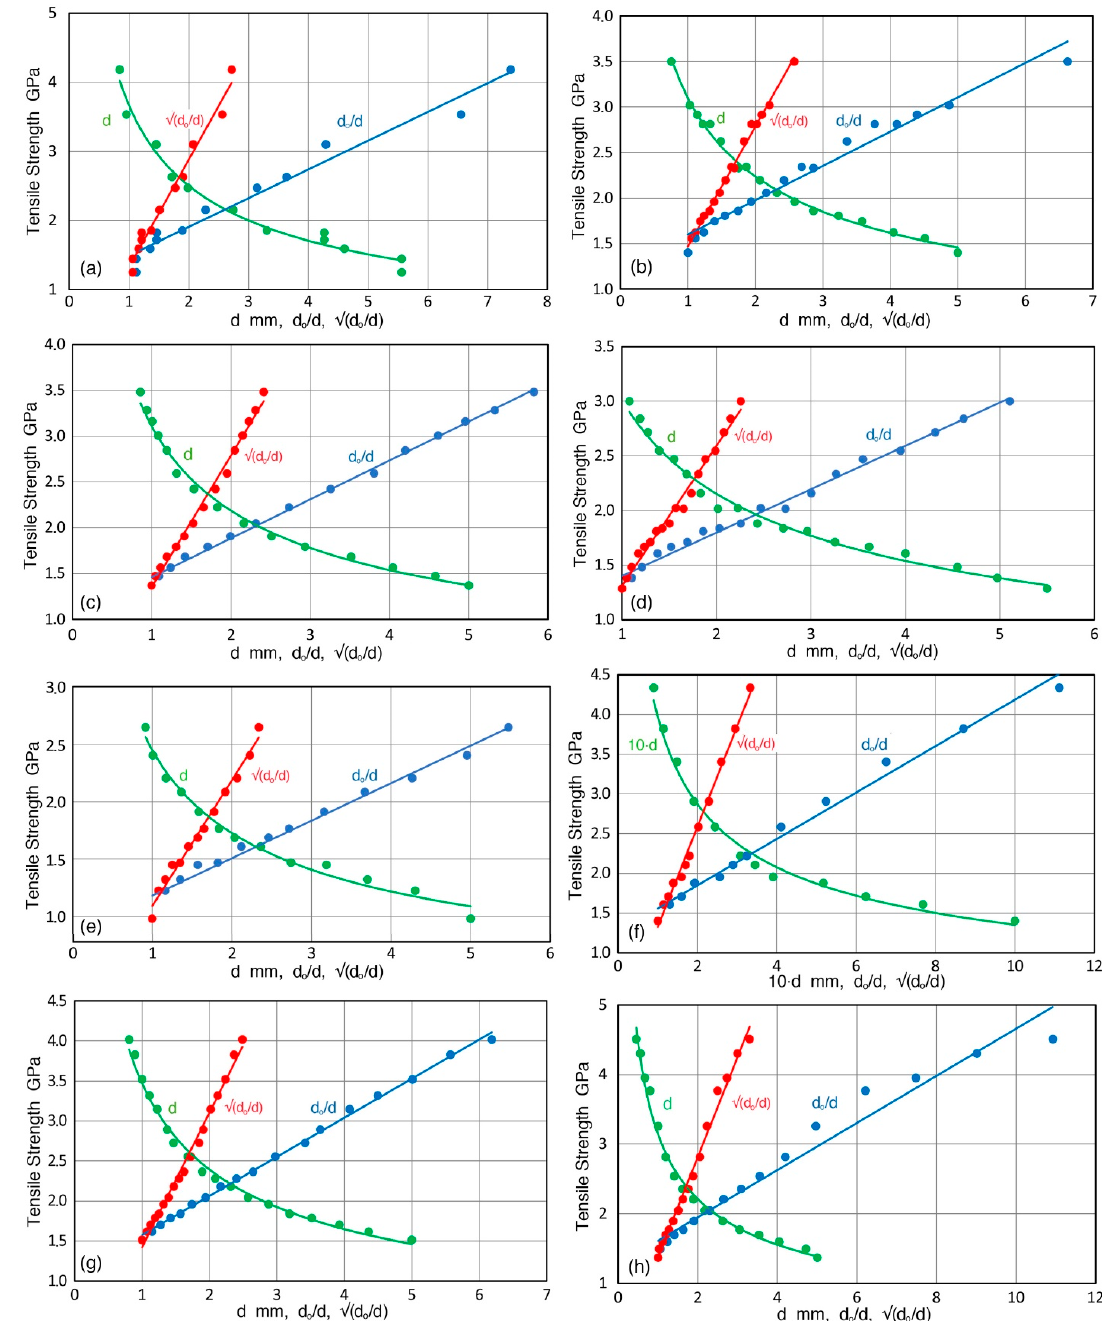
Figure 4. Tensile strength versus length parameters. ( a ) Embury data [30], ( b ) Langford [32], ( c ) Yamakoshi [47], ( d ) Ochiai [15], ( e ) Nam [41], ( f ) Tashiro [36], ( g ) Zelin [42], and ( h ) Tarui [49]. Green plot: σ ts versus d ; Red: σ ts versus √ ( d o / d ), Blue: σ ts versus ( d o / d ).